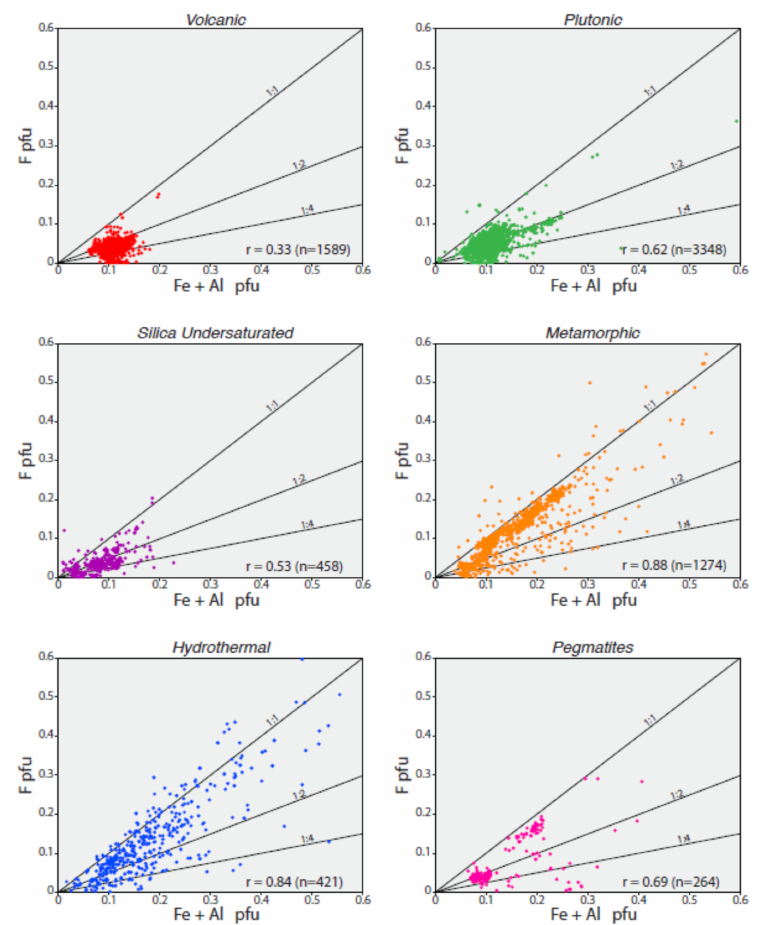
Figure 29. Fe + Al versus F in titanite from various environments. The correlation coefficients (r) and number of analyses (n) in each group are